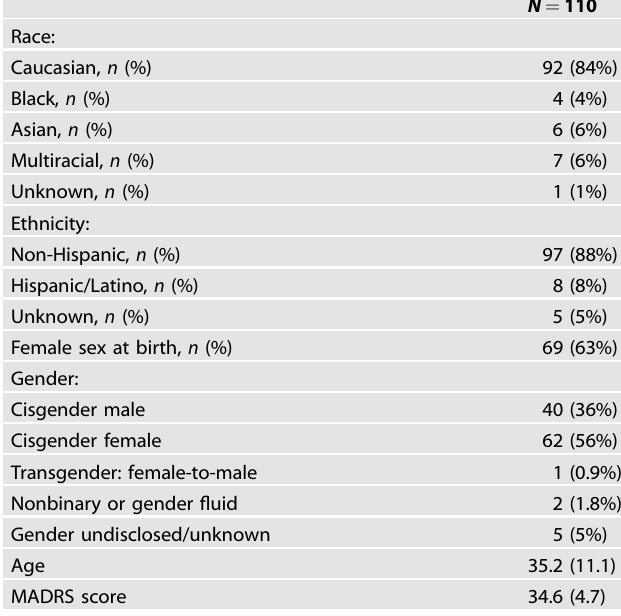
Table 1. Demographic and clinical characteristics of the